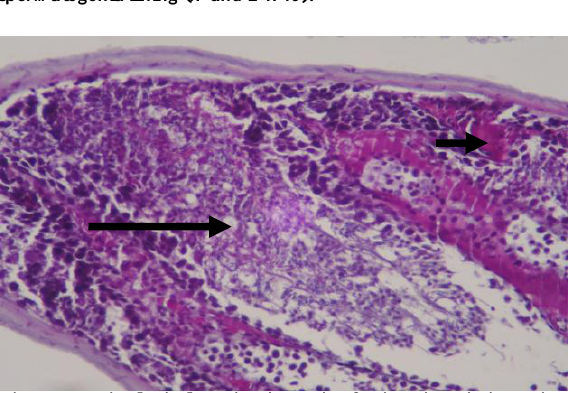
Figure, 3: Histological section in testis of mice given imipramine and C. sativus aqueous extract shows odema and regeneration of affected seminiferous tubules with appearance of spermatid in the lumen (H and E X40).